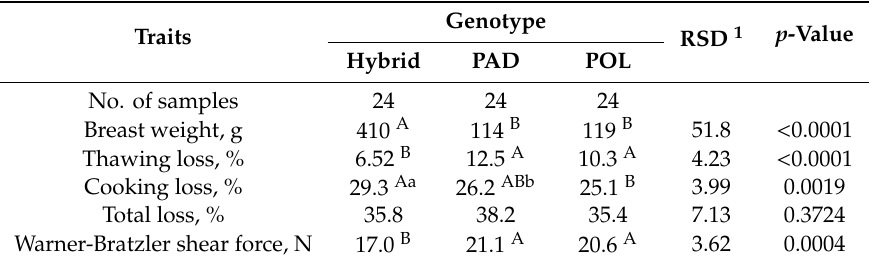
Table 2. E ff ect of genotype (Hybrid, PAD, POL) on breast weight, water holding capacity (thawing, cooking, and total loss), and Warner–Bratzler shear force. Genotype Traits RSD 1